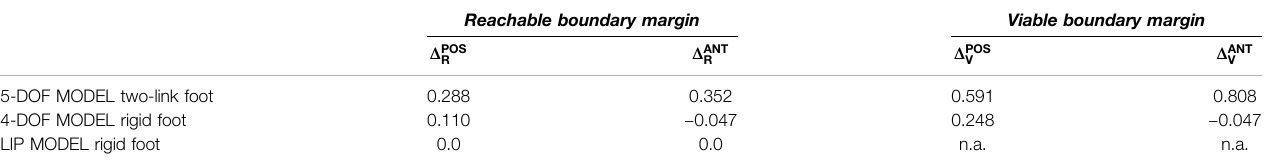
TABLE 1 | Anterior (ANT) and posterior (POS) nondimensional boundary margins of the general linear models of BoB calculated for the reduced- and higher-order body models. Reachable boundary margin